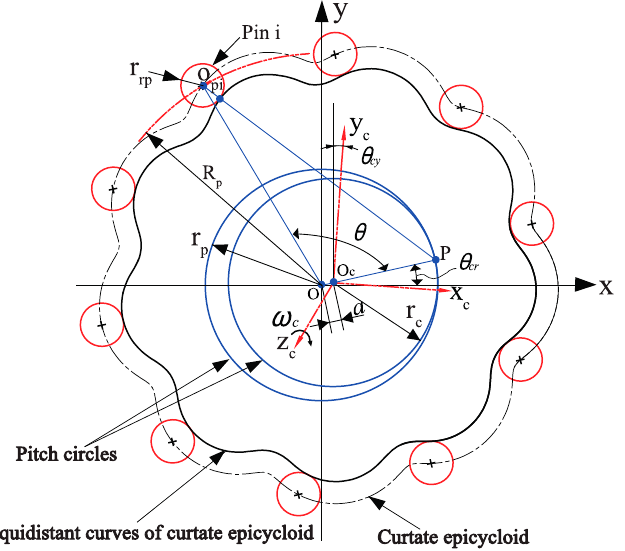
Figure 1. Traditional cycloid drive coordinates.